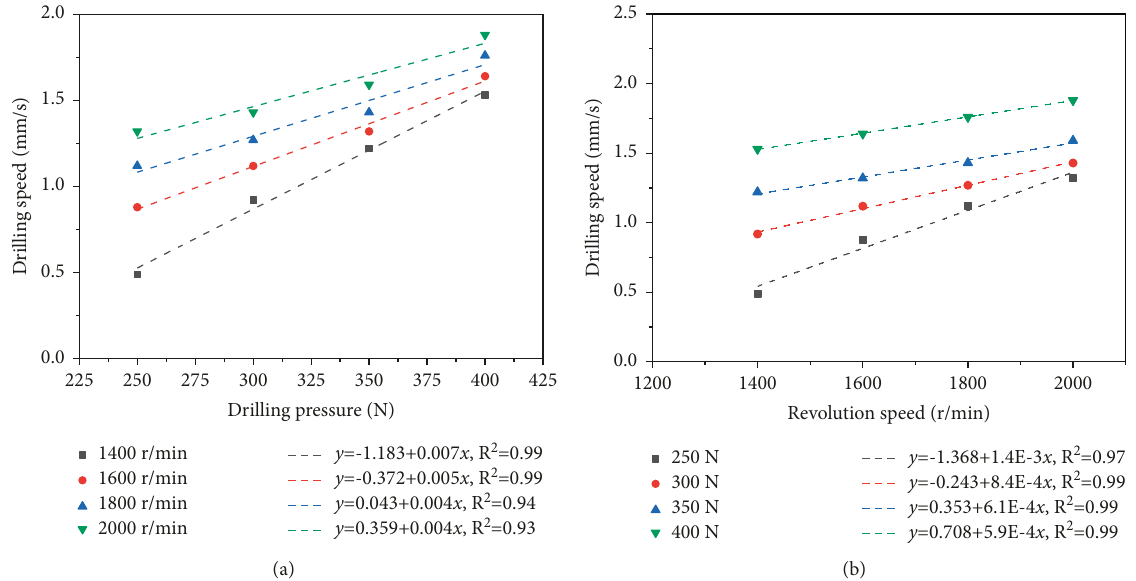
Figure 13: The variations of the DS with (a) the DP and (b) the RS of granite.